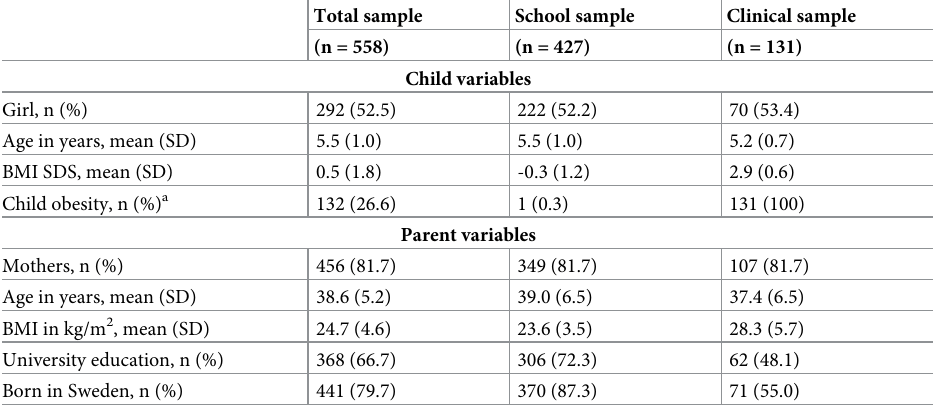
Table 1. Descriptive characteristics of the total/merged sample (n = 558) in the validation